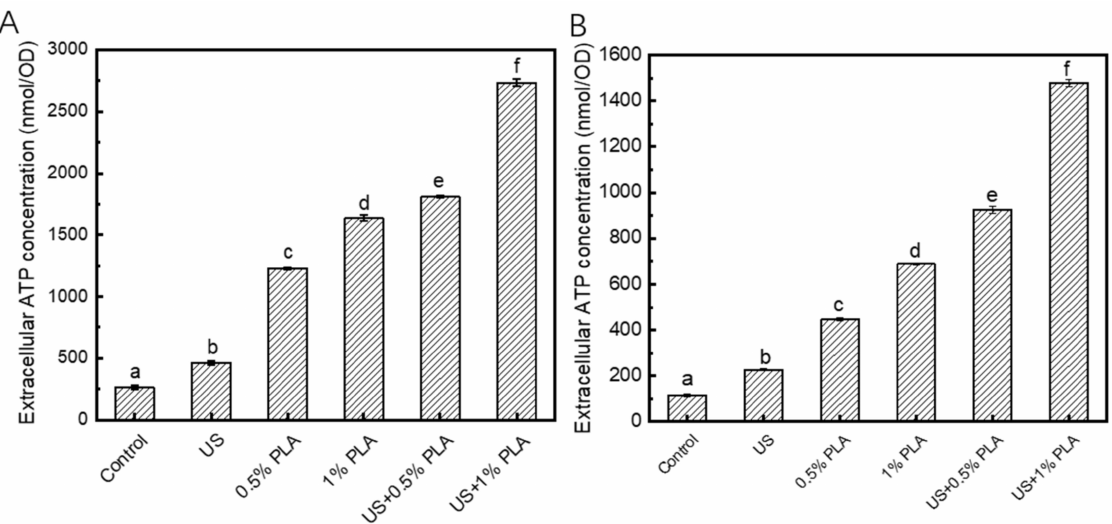
Figure 4. Changes in the contents of the extracellular ATP levels of S. aureus ( A ) and S. enteritidis ( B ) biofilm cells after different treatments. Different lower cases indicate significant difference ( p < 0.05). US, ultrasound; PLA, phenyllactic